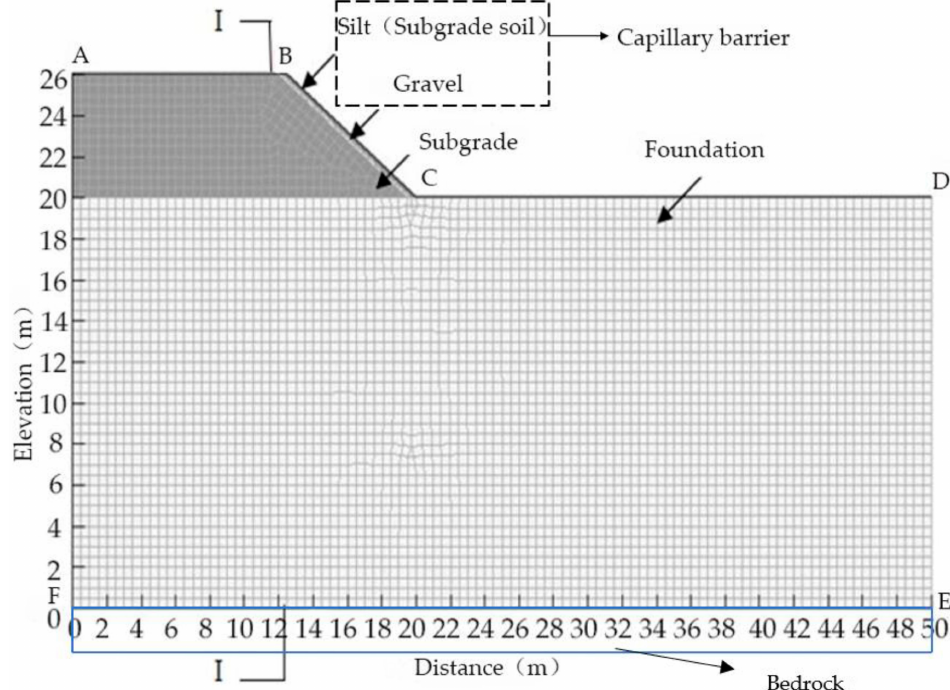
Figure 3. Mesh of the subgrade with a capillary barrier (unit: